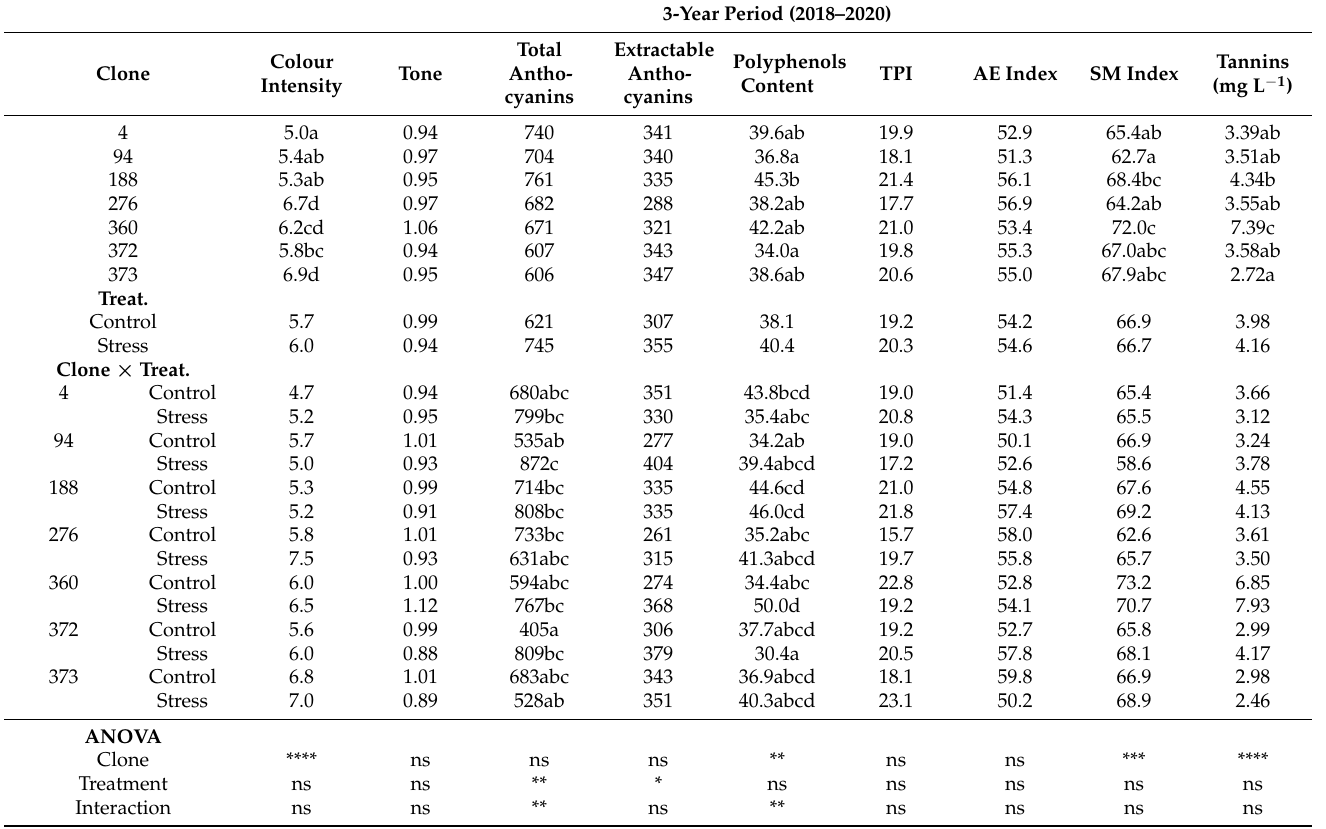
Table 7. Average annual values of berry phenolic quality at harvest for each clone, irrigation treatment, and the interaction (clones × irrigation treatment) during the 3-year period